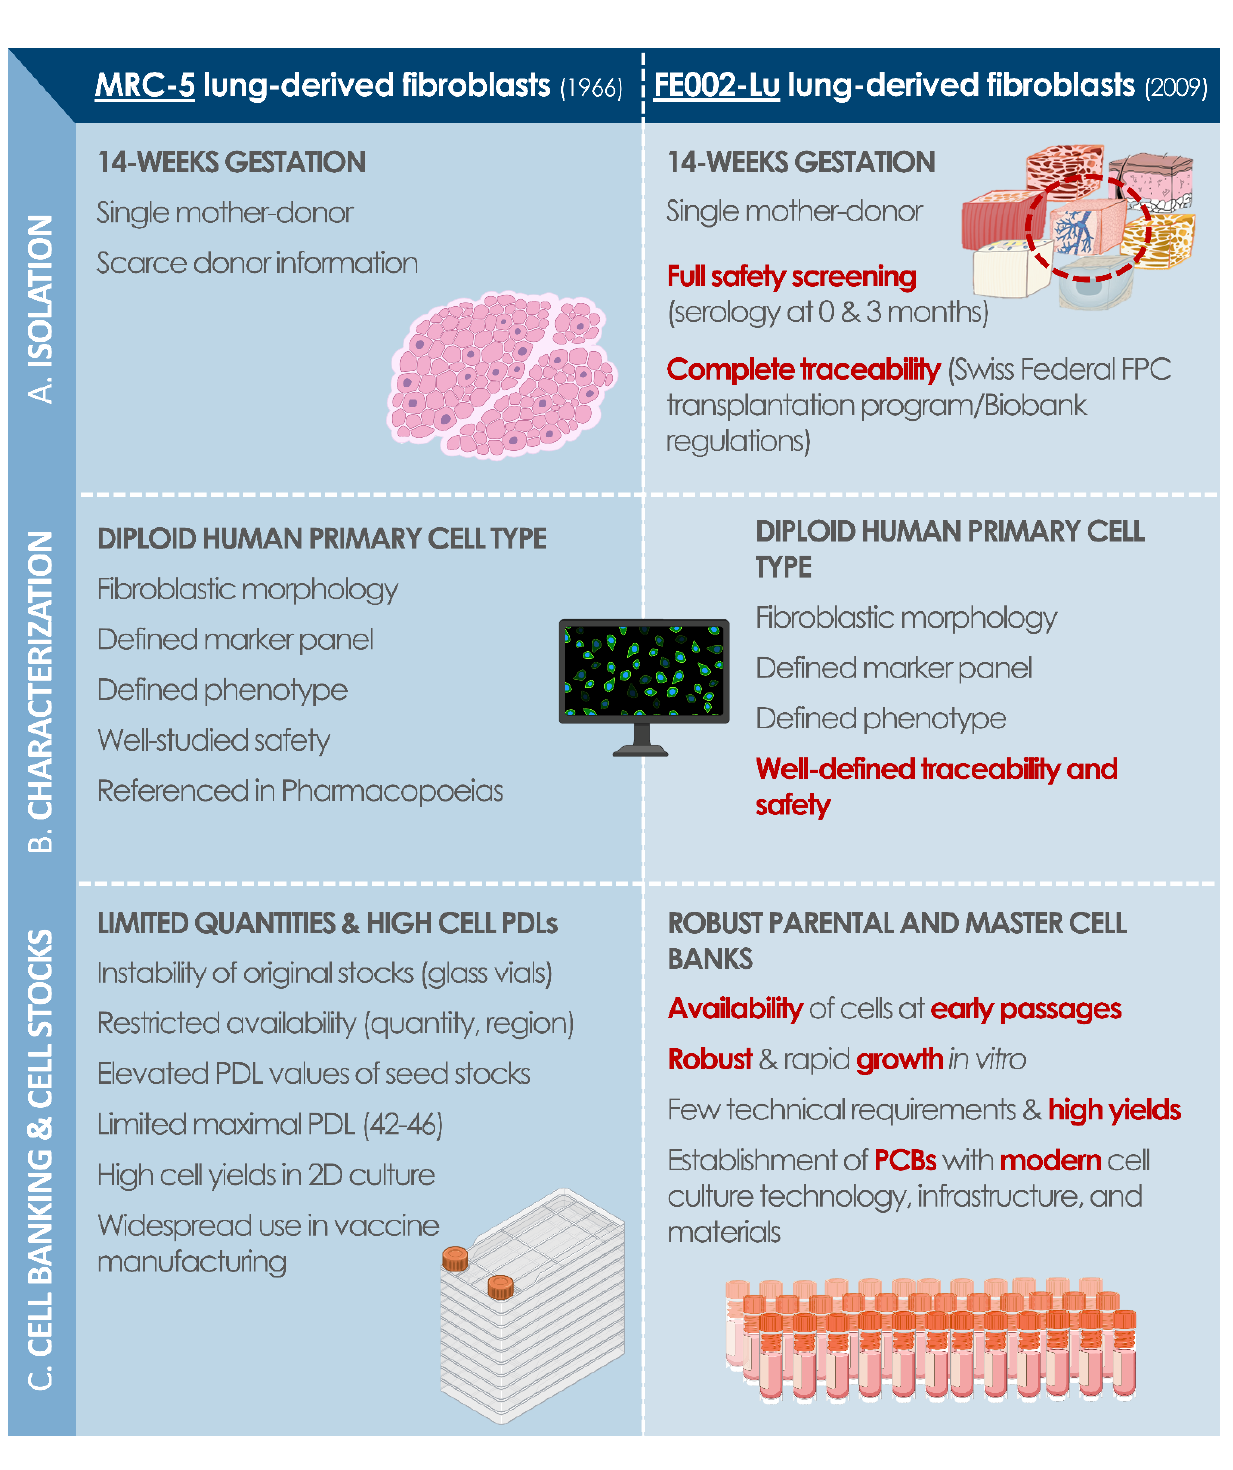
Figure 5. Modern cell source replacement potential, with a comparative assessment of MRC-5 and FE002-Lu diploid cell types, which were both established following cell isolation from prenatal lung tissue (i.e., 14 weeks of gestation). ( A ) Isolation of primary cells from donated tissue samples for initiation of in vitro culture. ( B ) Characterization data related to established cell type quality attributes. ( C ) Technical overview of the similarities and differences between both considered cell sources in terms of cell culture and cell banking. FPC, fibroblast progenitor cells; PCB, parental cell bank; PDL, population doubling level.